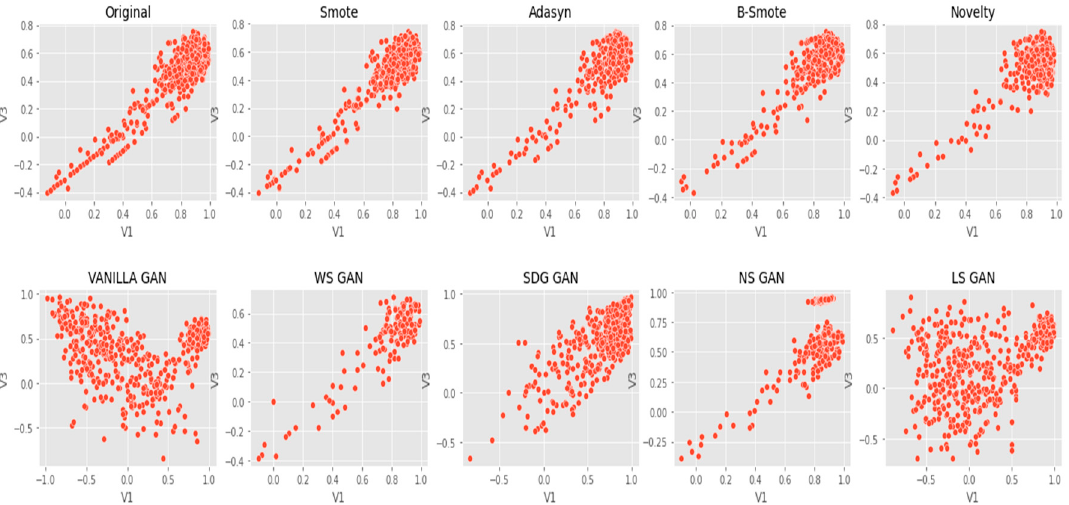
Figure 17. Bivariate V1 vs V3 Feature Distribution comparison of Original Data, SMOTE, ADAYSN, B-SMOTE, Novelty K-CGAN, Vanilla GAN, WS GAN, SDG GAN, NS GAN, and LS GAN methods.